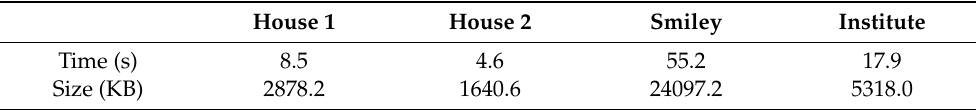
Table 6. Processing time and file size of converted models.